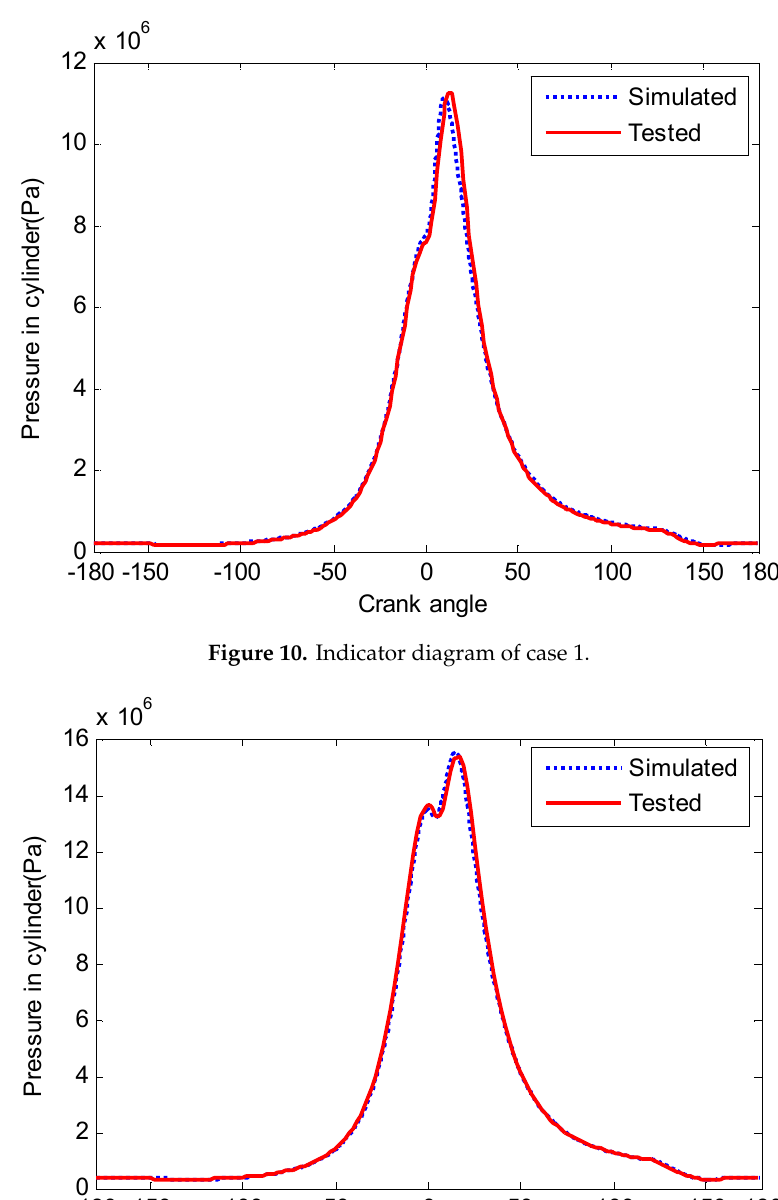
Figure 11. Indicator diagram of case 2.